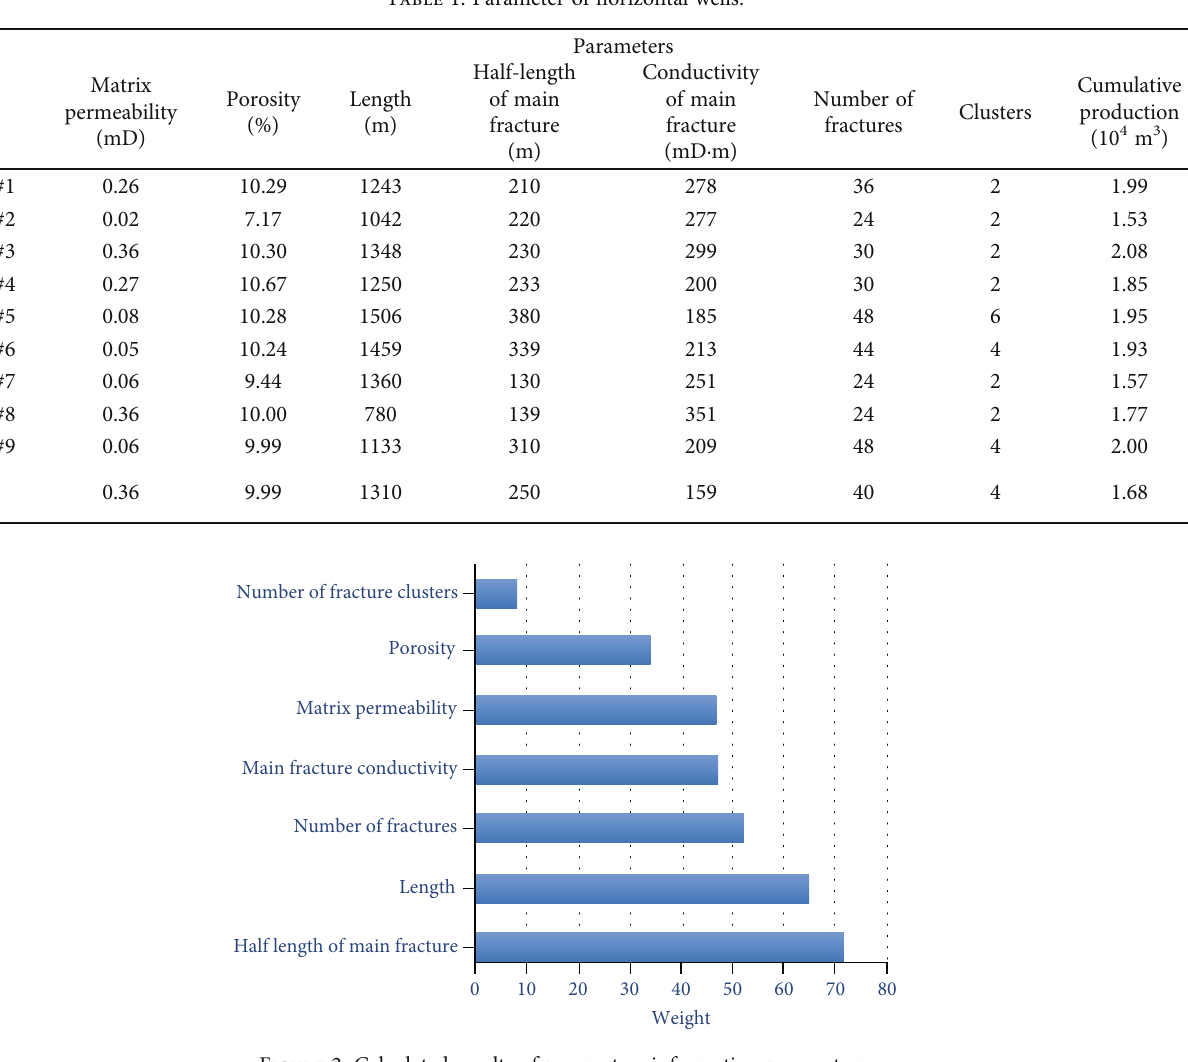
Table 1: Parameter of horizontal